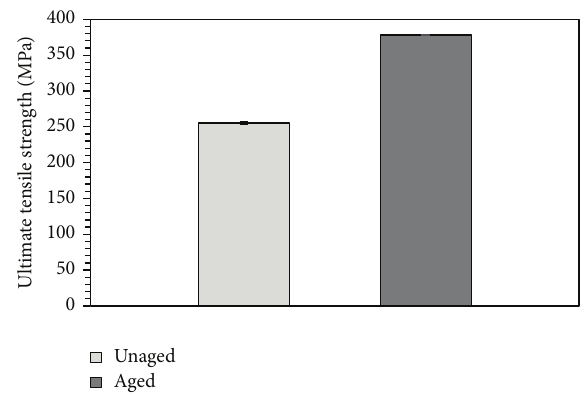
Figure 1: Change in ultimate tensile strength of EHG250-68-37 composite specimens subjected to 800 h oxidative aging at 82 ∘